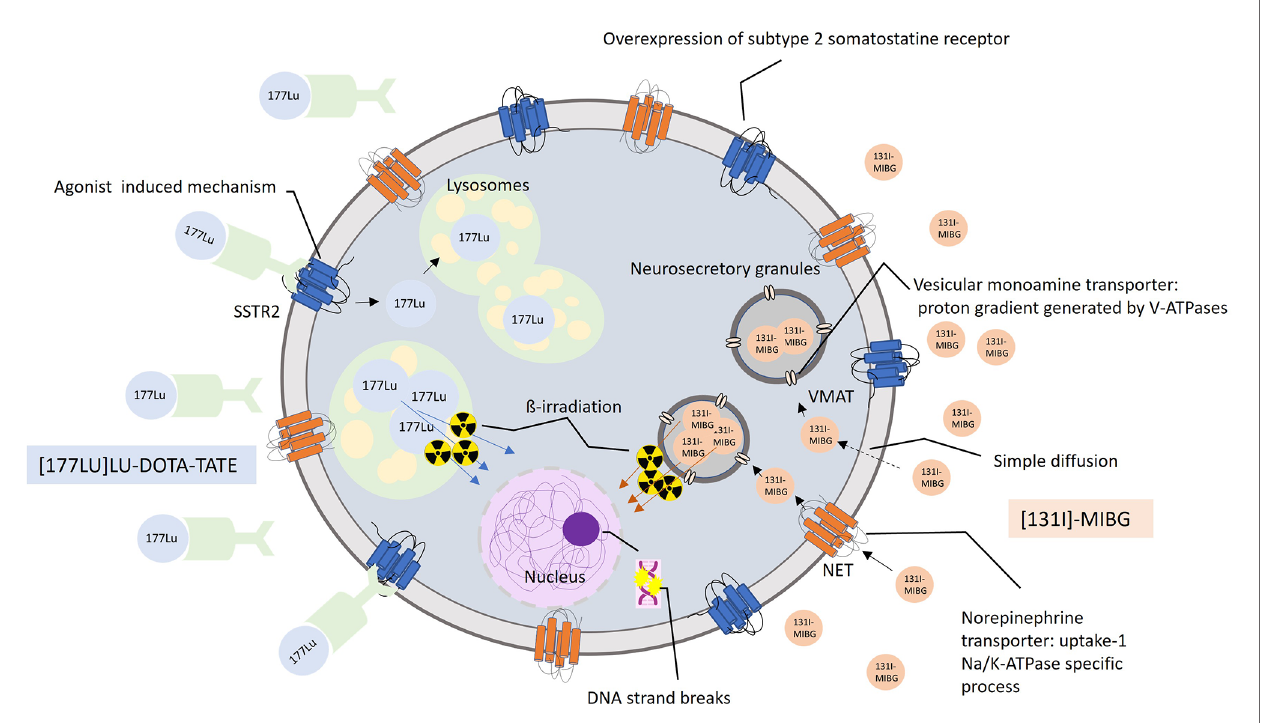
FIGURE 1 | Mechanism of action in [ 177 Lu]Lu-DOTA-TATE and [ 131 I]-MIBG